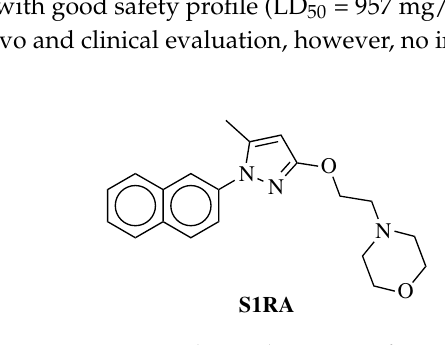
Figure 12. Chemical structure of S1RA